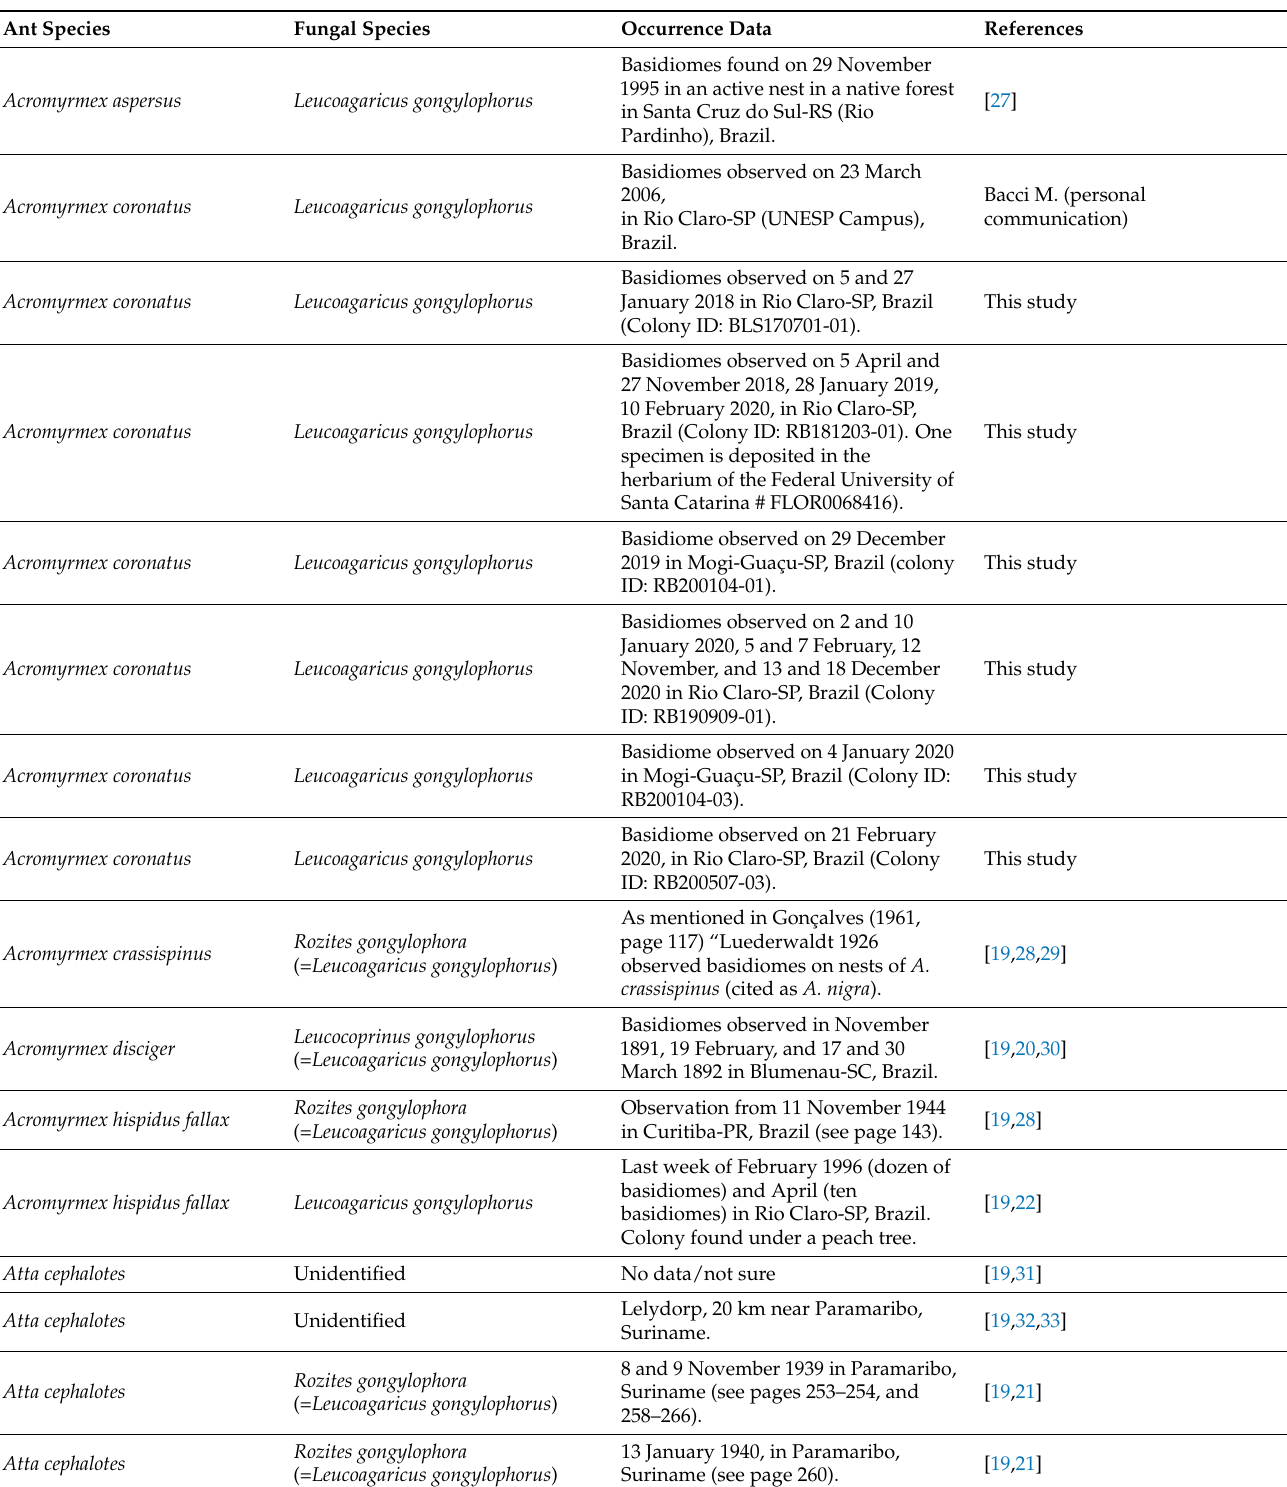
Table 1. Field occurrences of basidiomes in leaf-cutting ant nests. Data reviewed in the literature were compiled with new occurrence reports since the publication by Mueller (2002) [19]. A full version of the table is available in Table